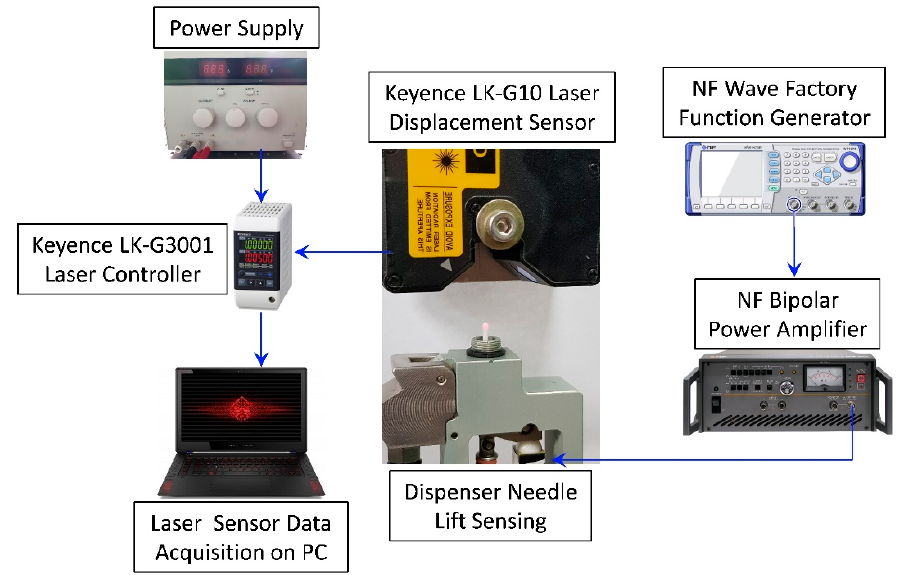
Figure 7. The experimental configuration for needle displacement measurement of jet dispenser.